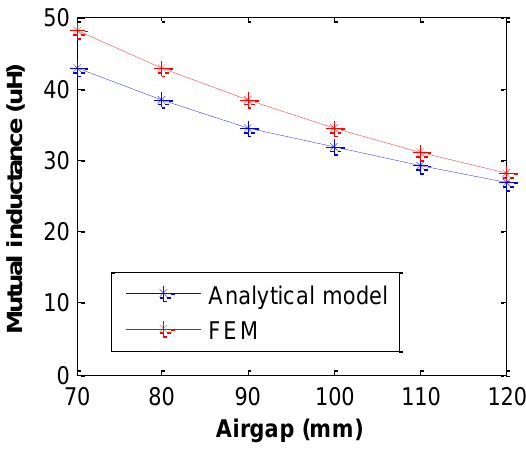
Figure 10. Impact of air-gap on the 7.7 kW system.